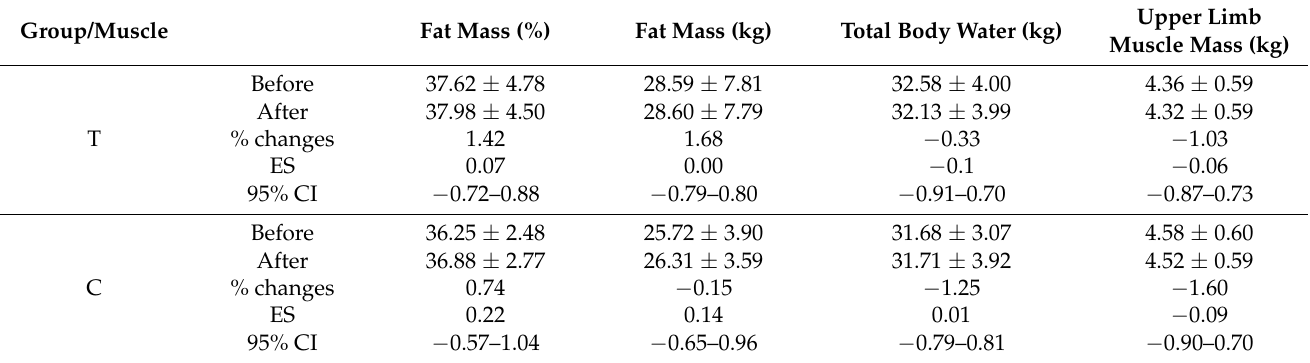
Table 3. Body composition changes following 6 weeks of